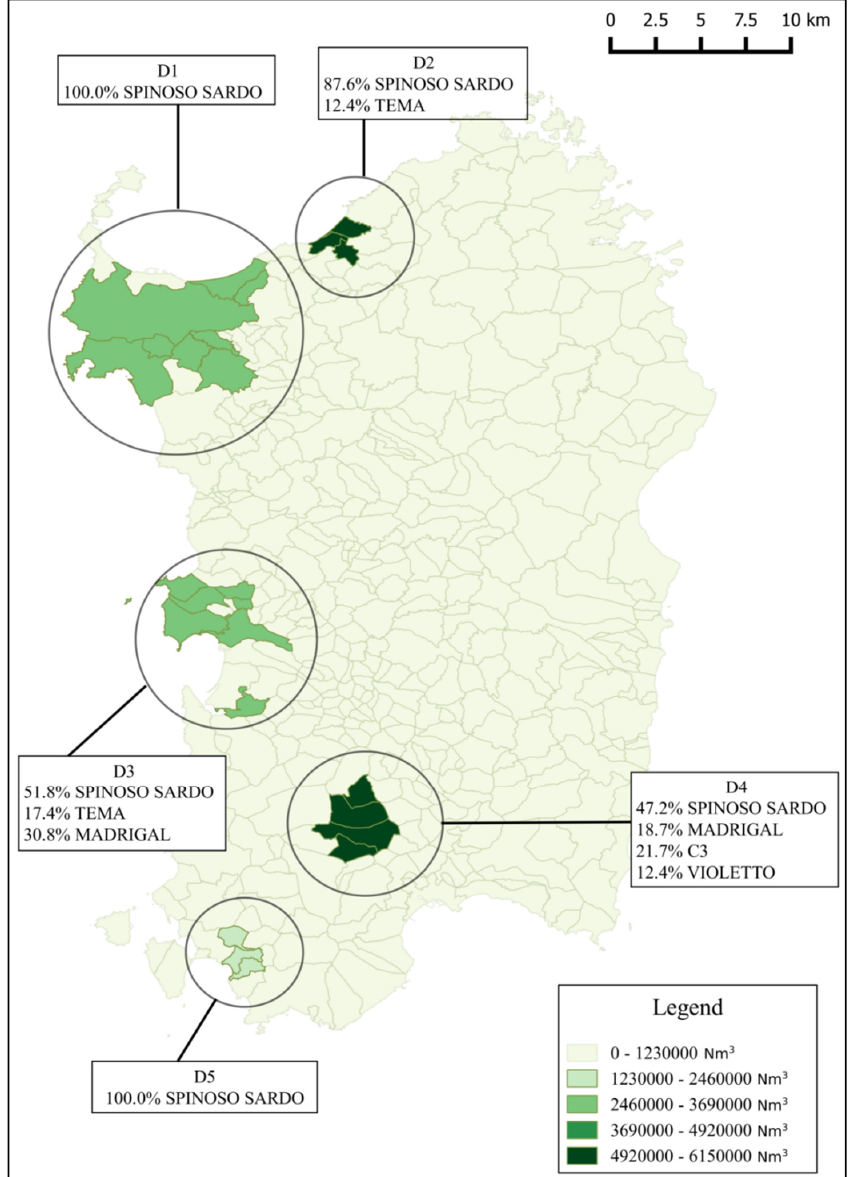
3 —average data under test condition j in Nm